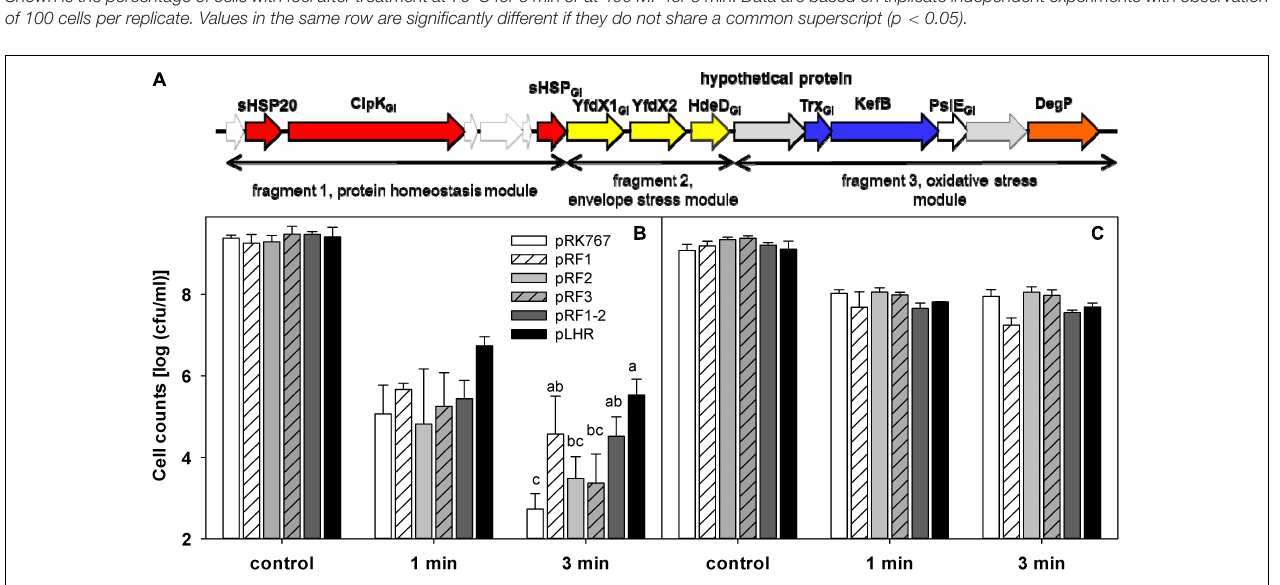
FIGURE 7 | Contribution of partial or full of the locus of heat resistance (LHR) to pressure resistance of the wild type strain E. coli MG1655 and its derivative strain E. coli LMM1010. (A) Schematic representation of the LHR1. For details, see legend to Figure 6 . (B) Pressure resistance of E. coli MG1655 carrying the plasmids indicated. (C) Pressure resistance of E. coli LMM1010 carrying the plasmids indicated. The strains carrying pRK767 or the derivatives of this vector with the full length LHR or the LHR fragments F1, F2, F3, or F1-2 were treated at 400 MPa at 20 ◦ C for 1 or 3 min. Data are shown as means ± standard deviation of triplicate independent experiments. Significant differences between cell counts were determined with one way ANOVA and the Holm-Sidak post hoc analysis; values with different superscripts are significantly different ( p <